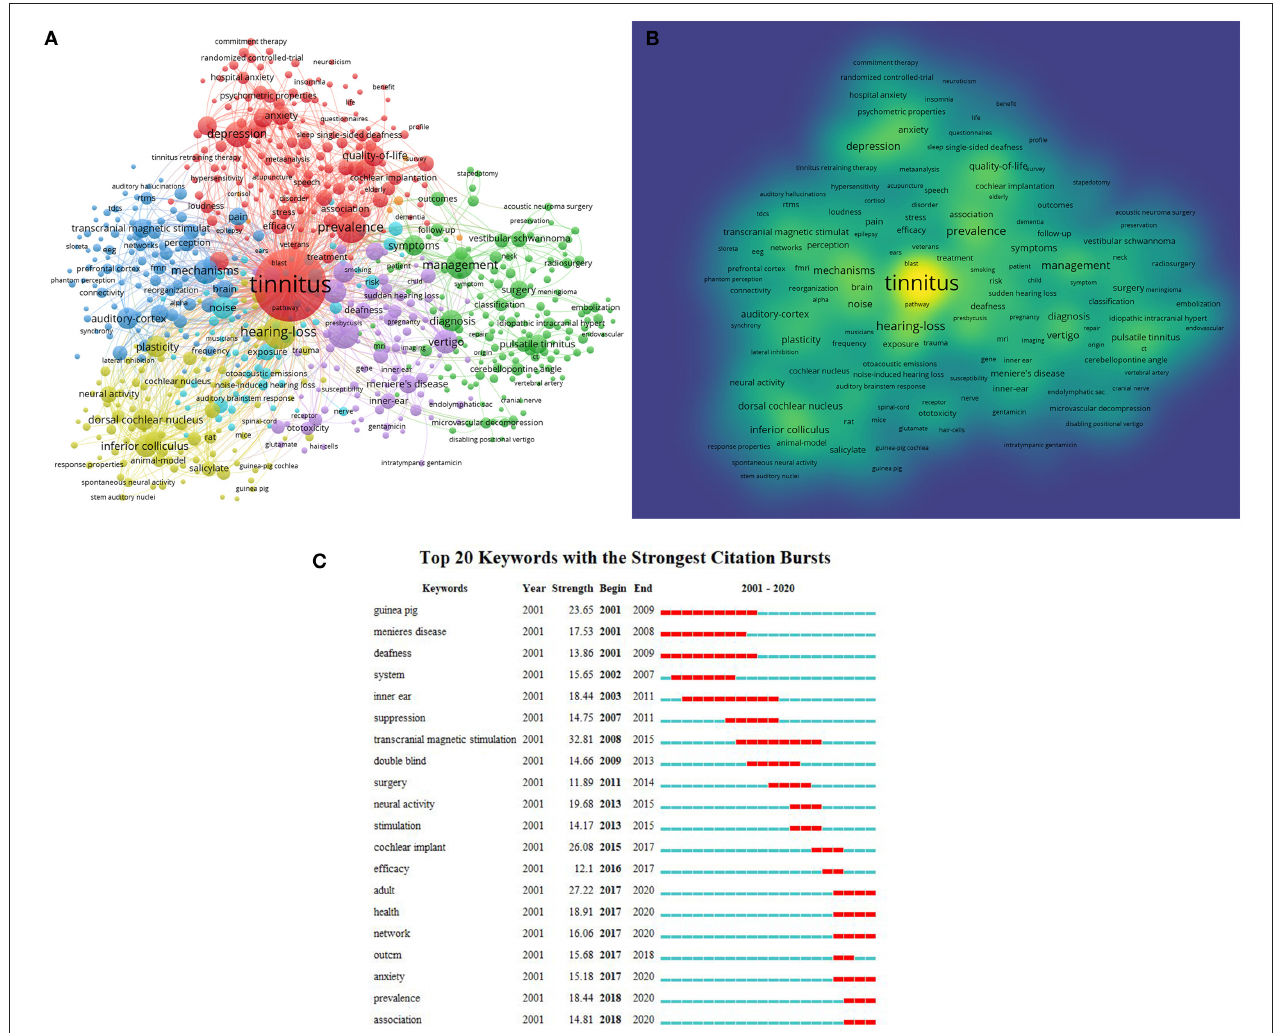
FIGURE 5 | Co-occurrence analysis of global research on tinnitus based on the WoSCC database from 2001 to 2020. (A) Mapping of keywords in the research field. (B) Distribution of keywords according to average frequency of appearance. Yellow keywords represent the highest frequency, followed by green and purple. (C) Keywords with the strongest citation bursts in tinnitus